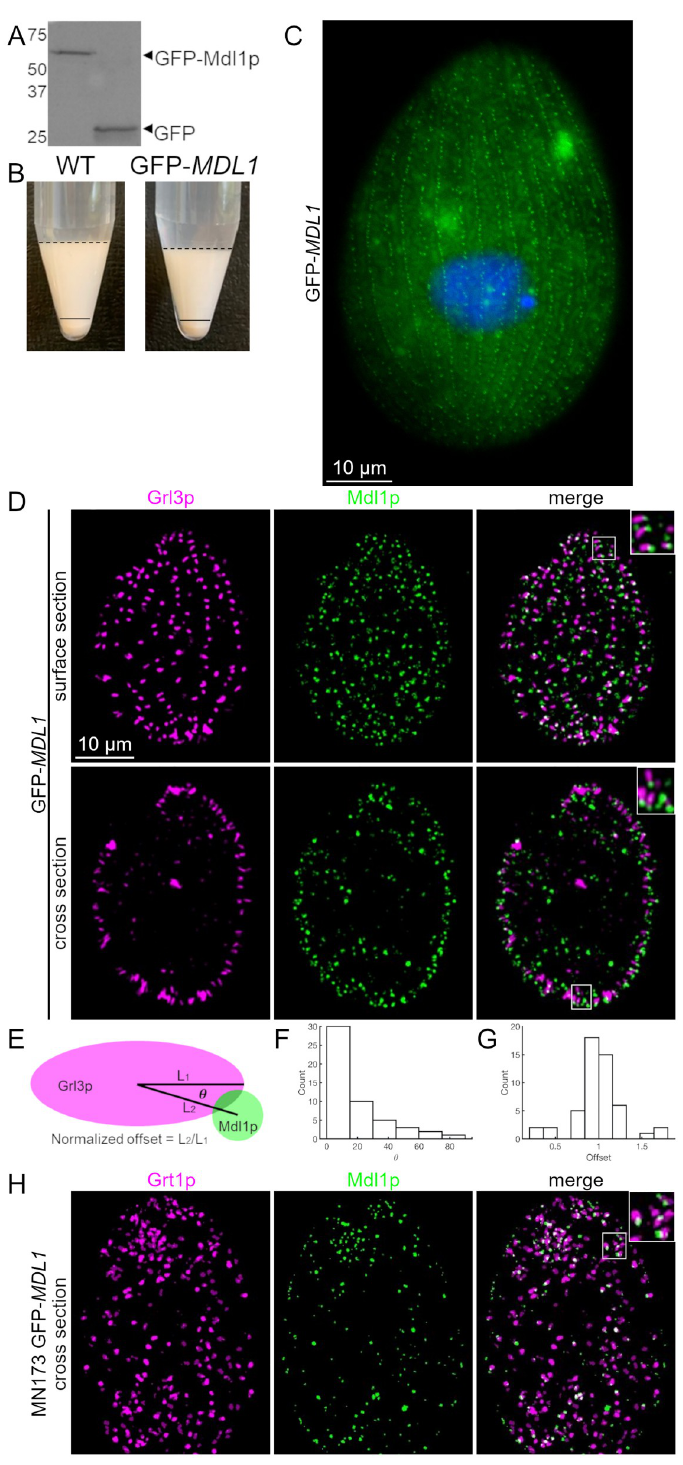
Fig 3. Mdl1p localizes to mucocyst tips. A. GFP-Mdl1p was immunoprecipitated from cryomilled extracts of cells expressing the transgene at the MDL1 locus. Immunoprecipitates were resolved by SDS-PAGE and immunoblotted with anti-GFP. As shown in the left lane, GFP-Mdl1p appears as a single band of MW ~65 kDa (based on 2 gels). The positions of MW standards are shown on the left, and GFP by itself is shown in the right lane. B. Dibucaine stimulation of mucocyst exocytosis. Cells in which all copies of MDL1 are GFP-tagged show wildtype levels of mucocyst